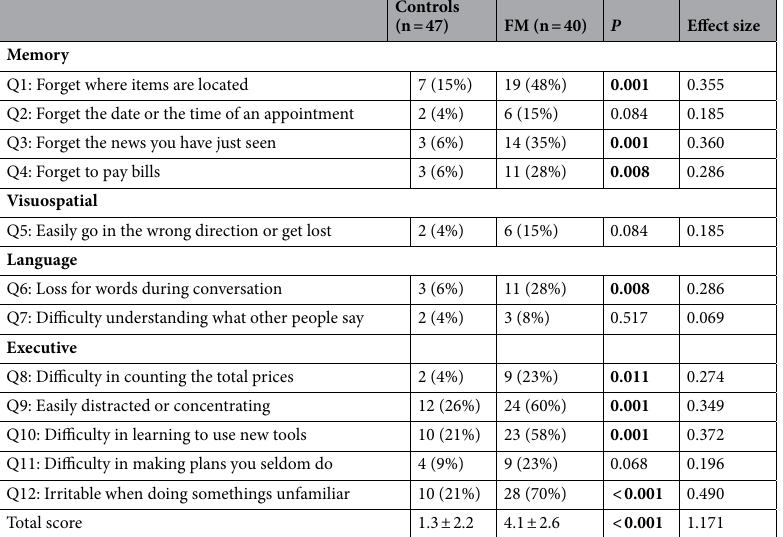
Controls (n = 47) FM (n = 40)